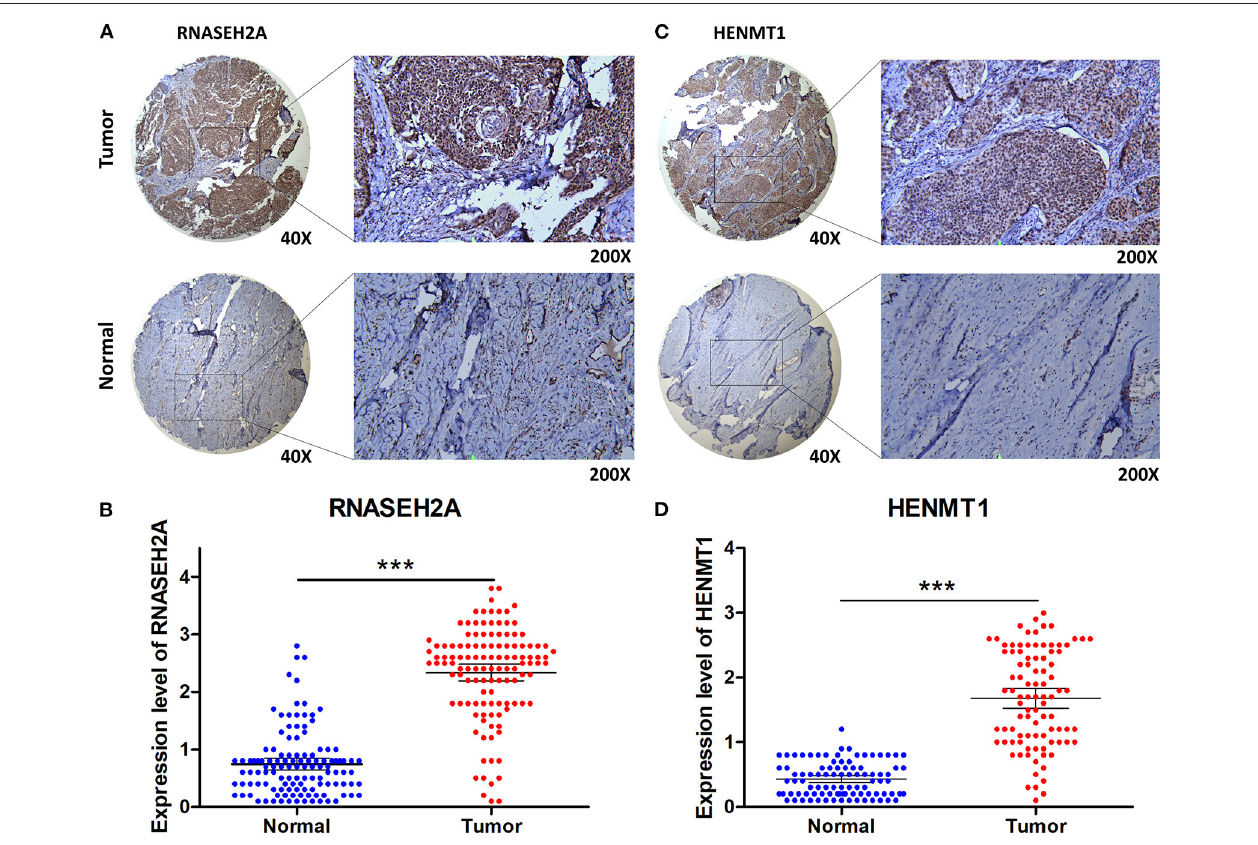
FIGURE 10 | Immunohistochemical verification of RNASEH2A and HENMT1. (A) Expression of RNASEH2A protein in cancer and normal samples. (B) Differential expression analysis of RNASEH2A in cancer and adjacent tissues in tissue expression microarray. (C) Expression of HENMT1 protein in cancer and normal samples. (D) Differential expression analysis of HENMT1 in cancer and adjacent tissues in tissue expression microarray. t-test was used to compare the differential expression between cancer and adjacent samples. *** P <